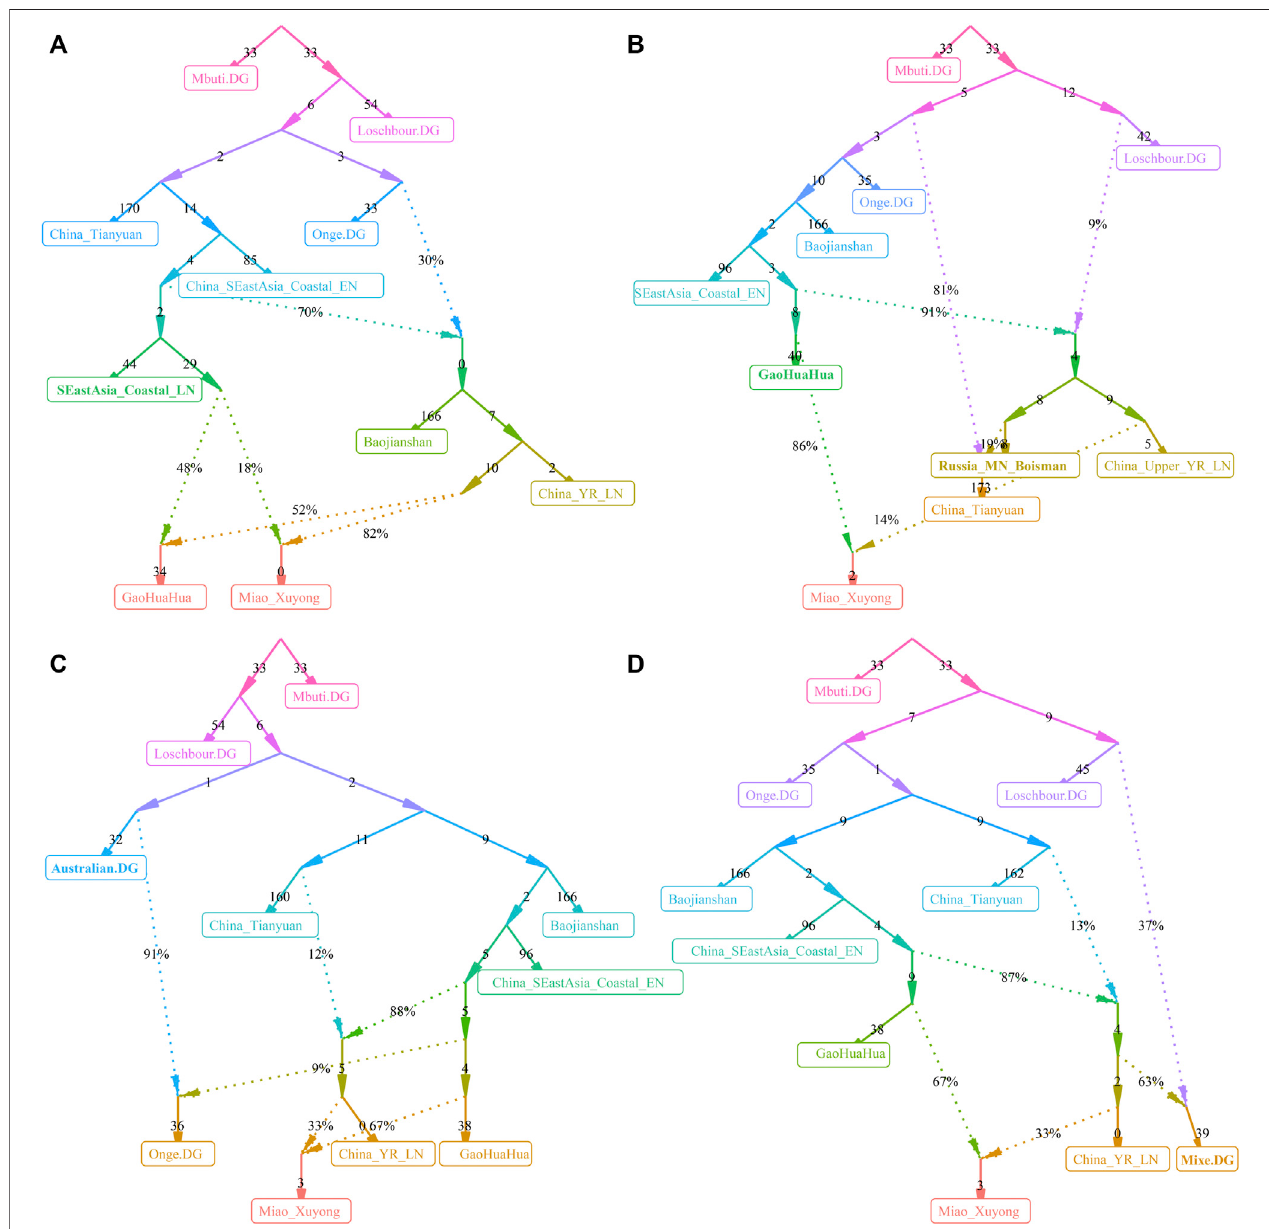
FIGURE6| Deep population history reconstruction based on thebest- fi tted qpGraph models. Differentframeworks in theqpGraph-based models adding the late Neolithic Fujian population (SEastAsia_Coastal_LN, (A) , Mongolian Plateau Hunter-Gatherer (Boisman, (B) , Australian (C) , and Mixe (D) .